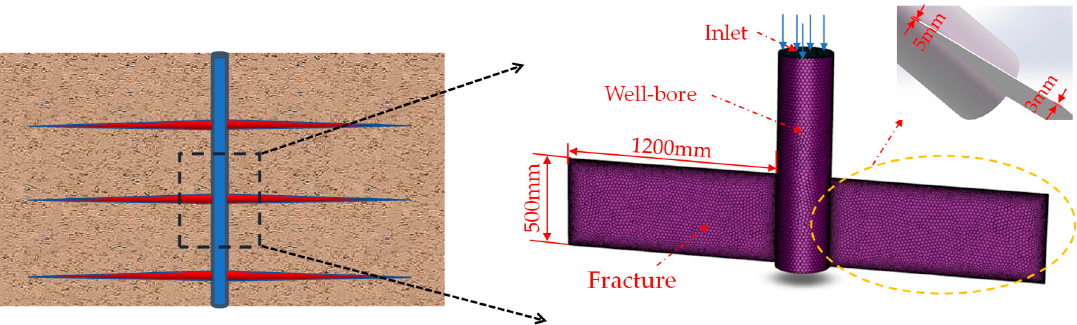
Figure 1. Wellbore fracture model.